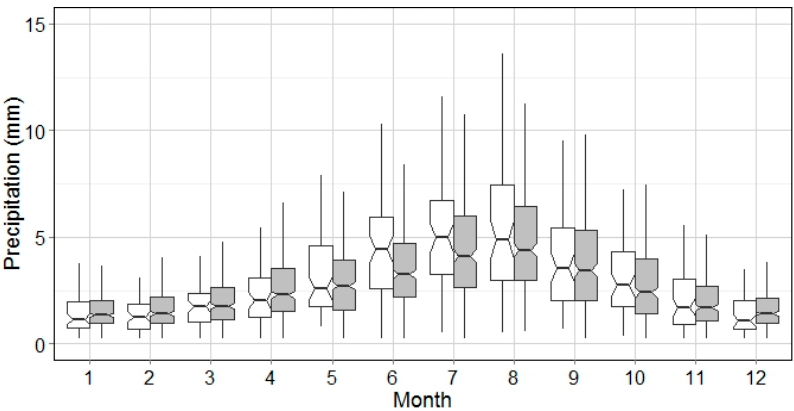
Figure 11. Boxplots of WEP means with WED less than 5 h (Historical: White, Synthetic: Grey).